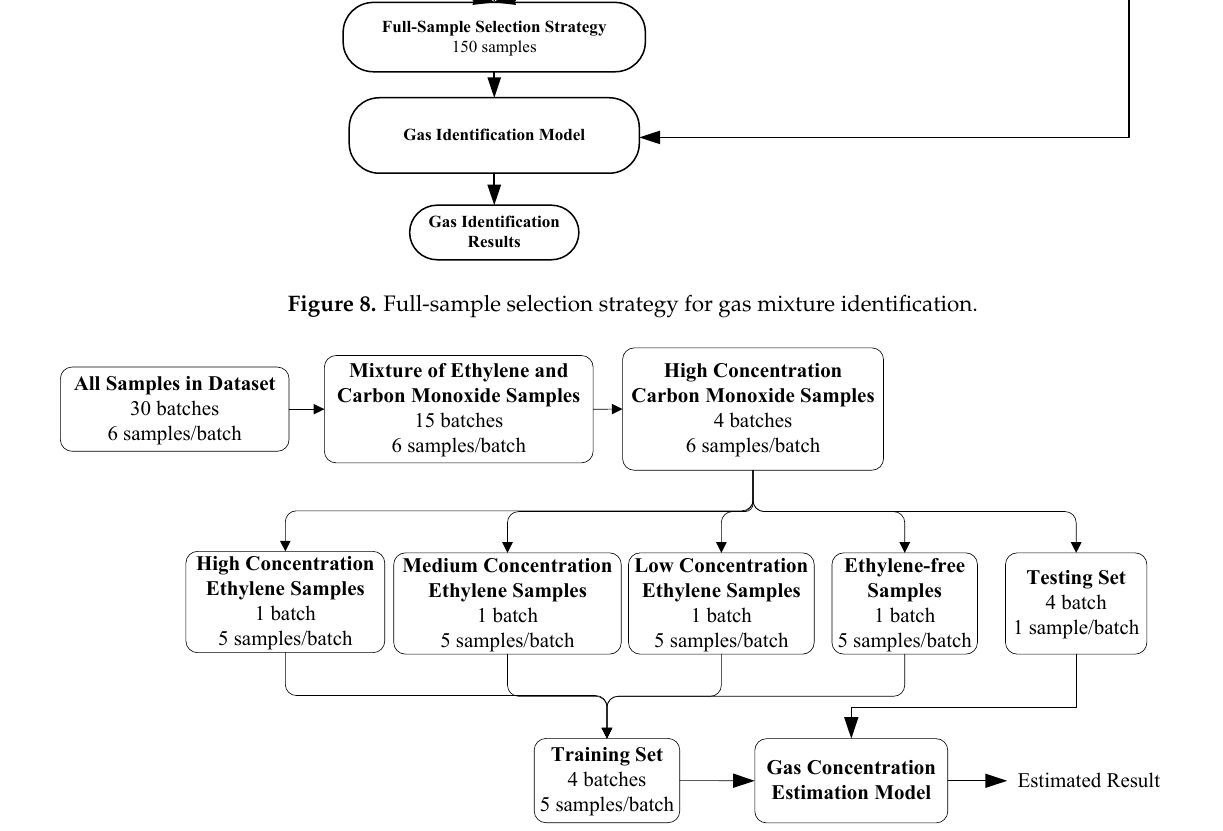
Figure 9. Sample selection strategy for ethylene as a target gas under the conditions of high-concentration carbon monoxide as a background gas.